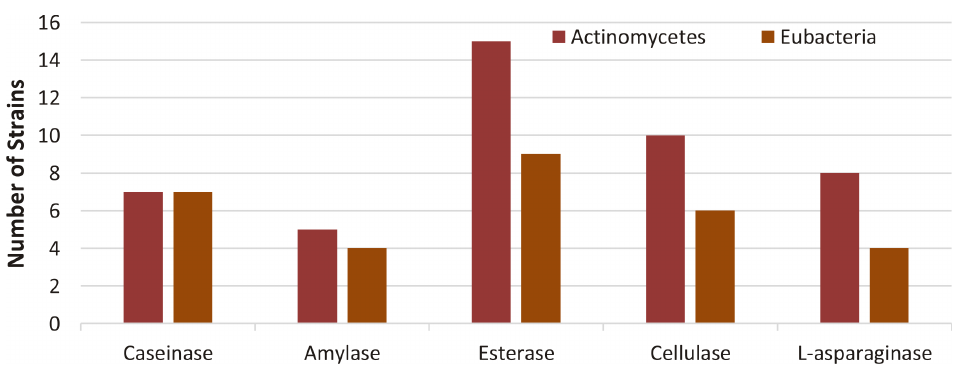
Fig. 1. Distribution of enzyme producing strains isolated from soil samples based on confirmatory qualitative assay test.